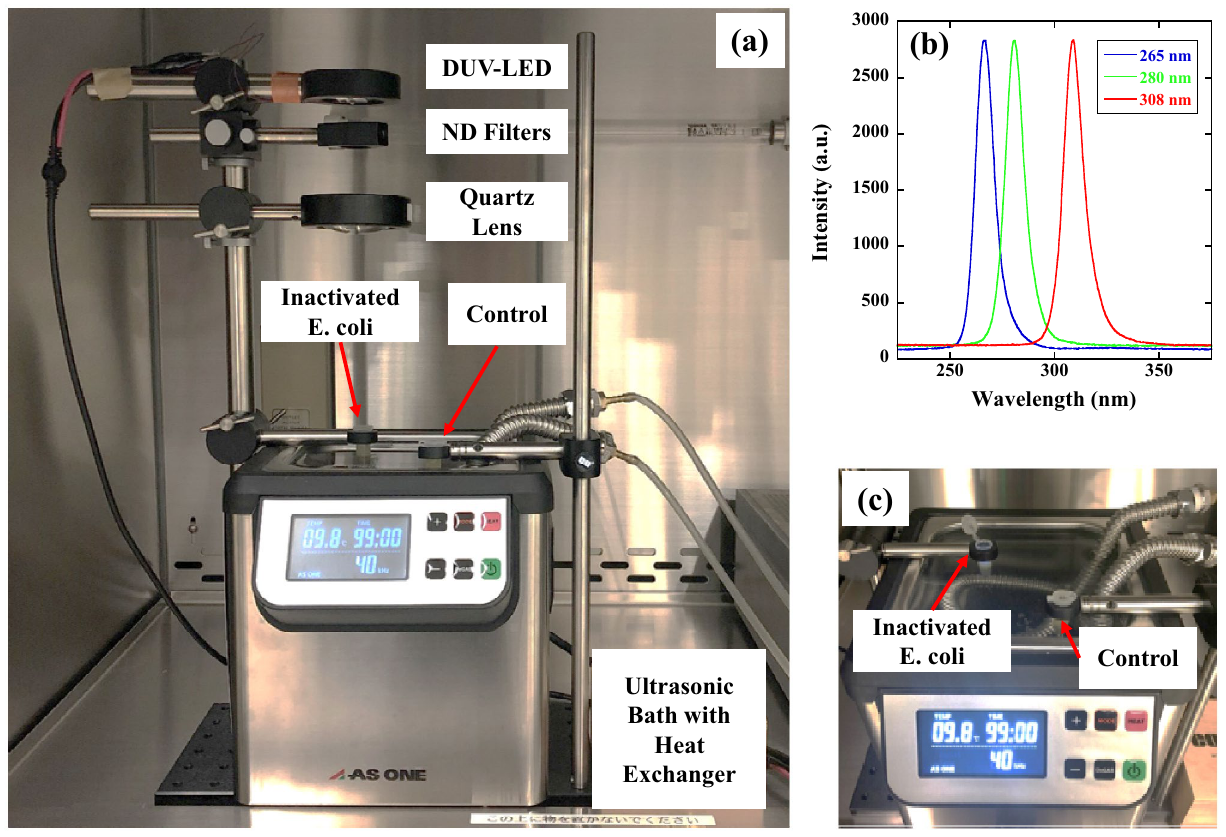
Figure 1. Optical setup of the UV inactivation system and emission spectrum of UV-LEDs. ( a ) Optical setup of the UV-LED inactivation system. ( b ) Emission spectra of 265 nm, 280 nm, and 308 nm UV-LEDs. These LEDs exhibited peak wavelength emissions at 266.5 nm, 280.6 nm, and 308.8 nm, respectively, with full-width at half-maximum bandwidths of 11.1 nm, 11.5 nm, and 12.0 nm. ( c ) Photograph of an E. coli bacterial sample irradiated by the UV-LED in an ultrasonic bath. An E. coli bacterial sample without UV irradiation was also placed in the ultrasonic bath as a control sample to account for the inactivation caused by ultrasonic